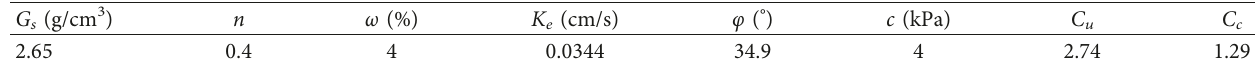
Figure 4: Diffusion radius of different cement grouts. (a) Power-law grout, (b) Bingham grout, and (c) Newtonian grout. Table 2: Physical and mechanical parameters of the used